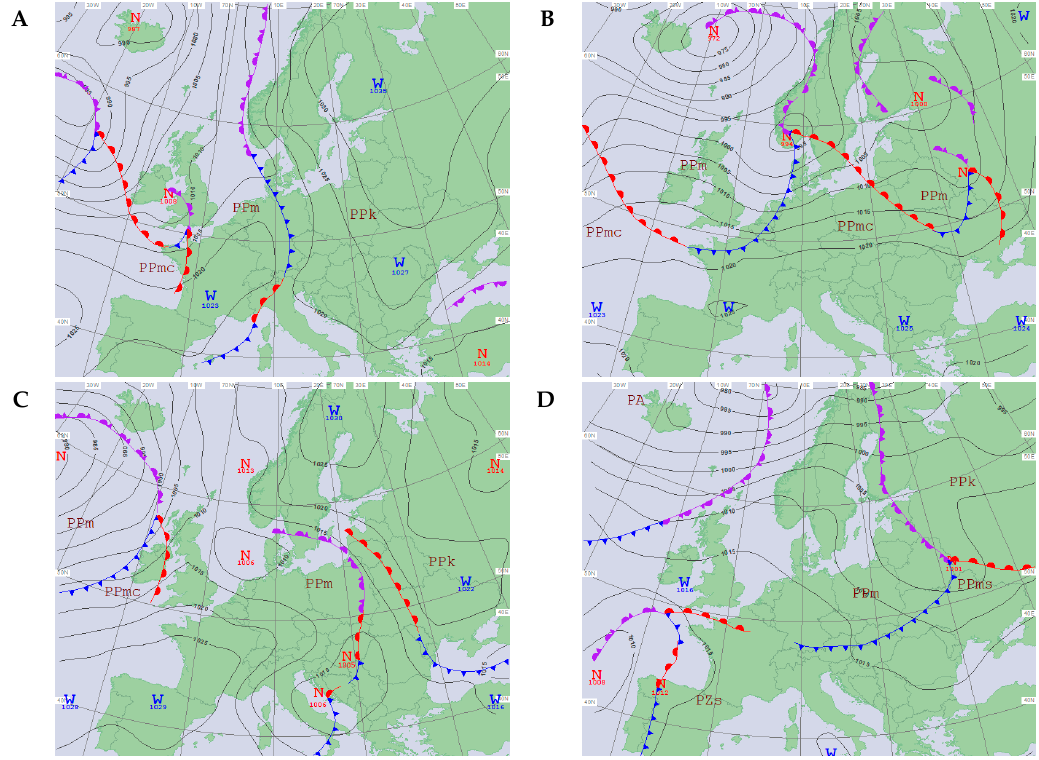
Figure 5. Weather charts respectively (W—High pressure area, N—Low pressure area): ( A ) 1 X, ( B ) 12 X, ( C ) 23 X, ( D ) 3 XI.